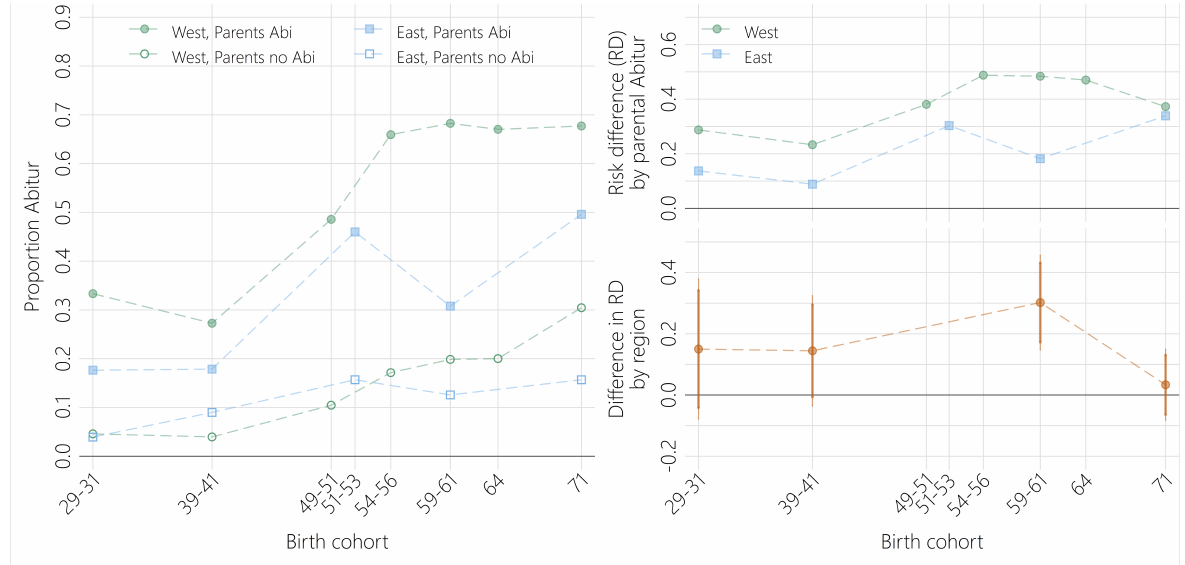
Figure 3: Change in IEO across birth cohorts in East and West Germany before reunification. Risk differences pertain to parental education. Difference in risk difference pertains to East and West